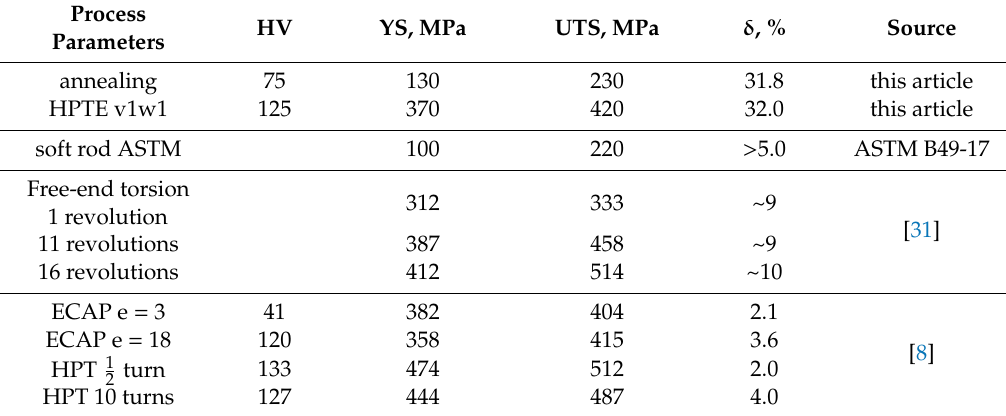
Table 2. Vickers hardness (HV), yield strength (YS), ultimate strength (UTS) and elongation to failure ( δ ) of CP Cu after HPTE and after some other SPD processing